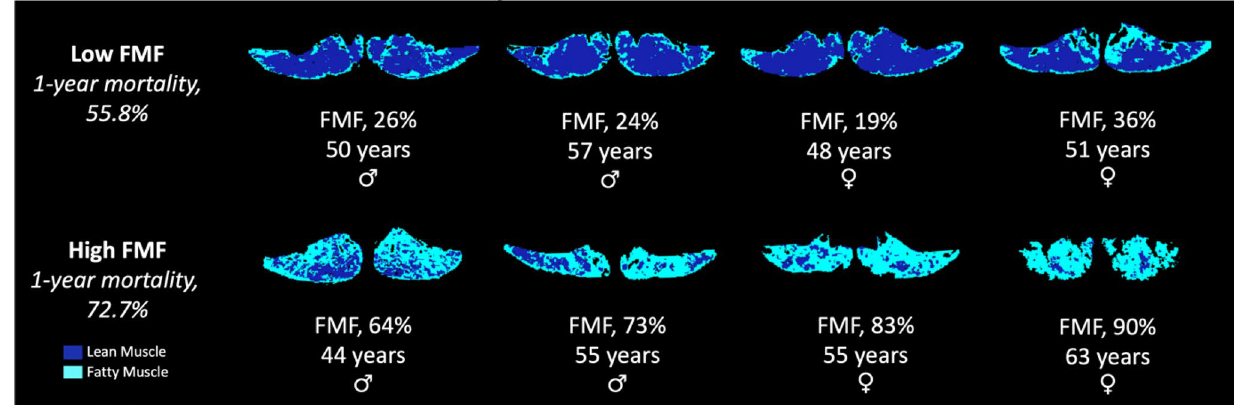
Figure 4. Exemplary patients. The paraspinal skeletal muscle area at the level of the superior mesenteric artery was separated into areas of fatty and lean muscle based on attenuation threshold ranges from CT scans around 4 days of ECMO implantation for acute respiratory failure. FMF was calculated at the fatty muscle area related to the total skeletal muscle area. Based on median FMF of the entire study population (n = 87), patients were binarized with a cutoff value of > 44% to define high FMF. Panels show exemplary patients with high and low FMF with corresponding 1-year mortality rates. CT computed tomography, ECMO Extracorporeal membrane oxygenation, FMF Fatty muscle fraction.